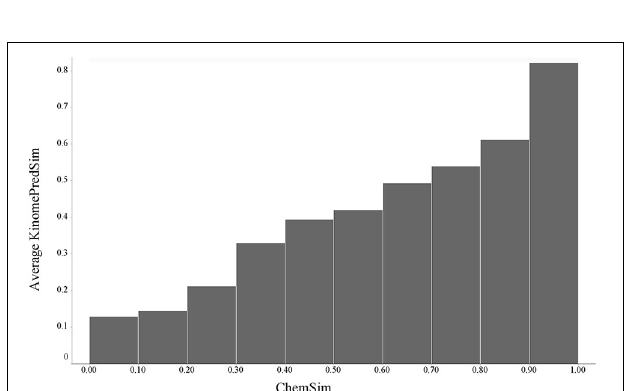
FIGURE 5 | Global trend of kinase binding profile similarities (KinomeSim) and chemical structure similarities (ChemSim) for 78 compounds, illustrated as average KinomePredSim values by ChemSim ranges.